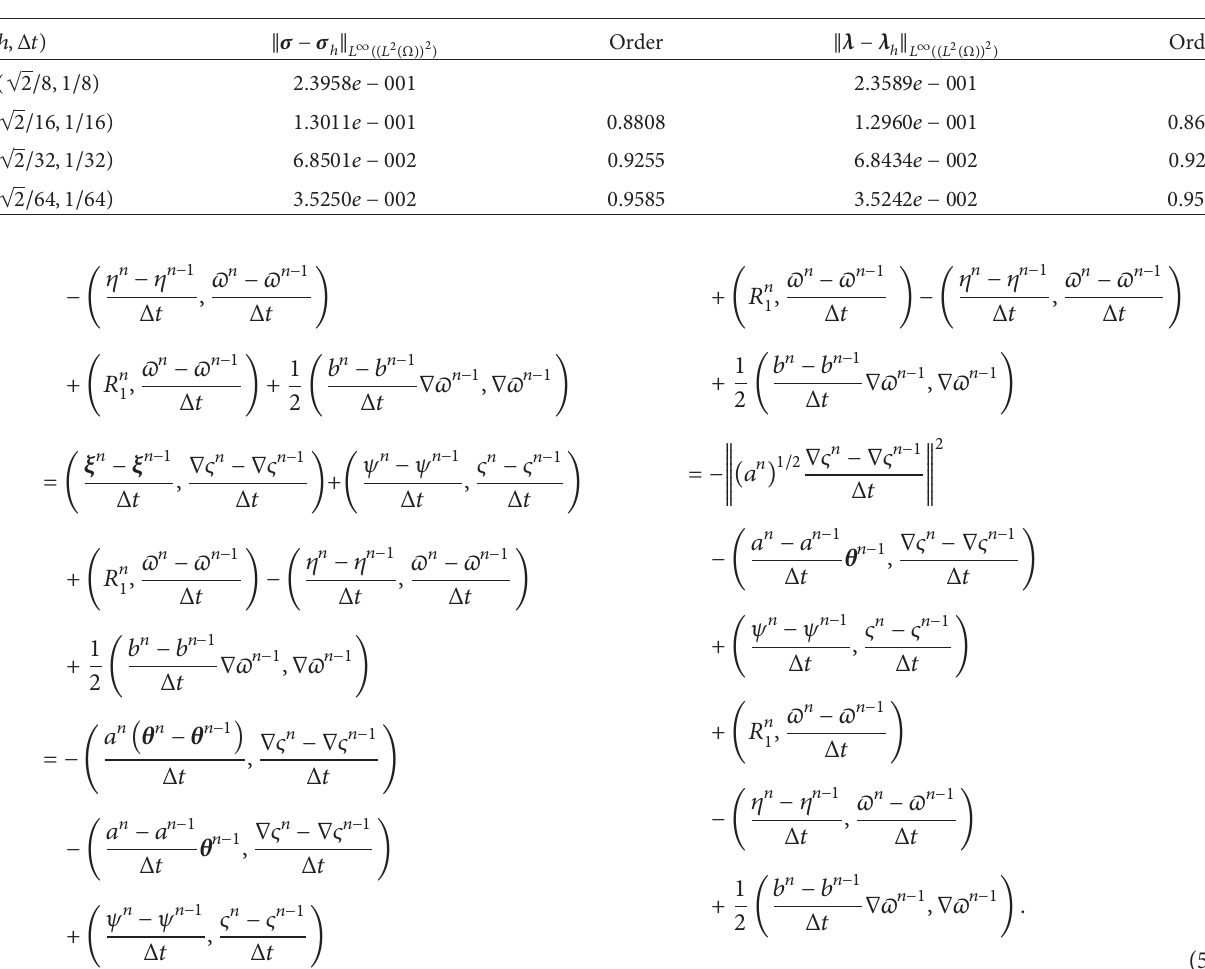
Figure 5: Surface for exact solution 𝜆 = ( 𝜆 1 , 𝜆 2 ) . Table 3: (𝐿 2 ) 2 -norm and convergence order for 𝜆 and 𝜎